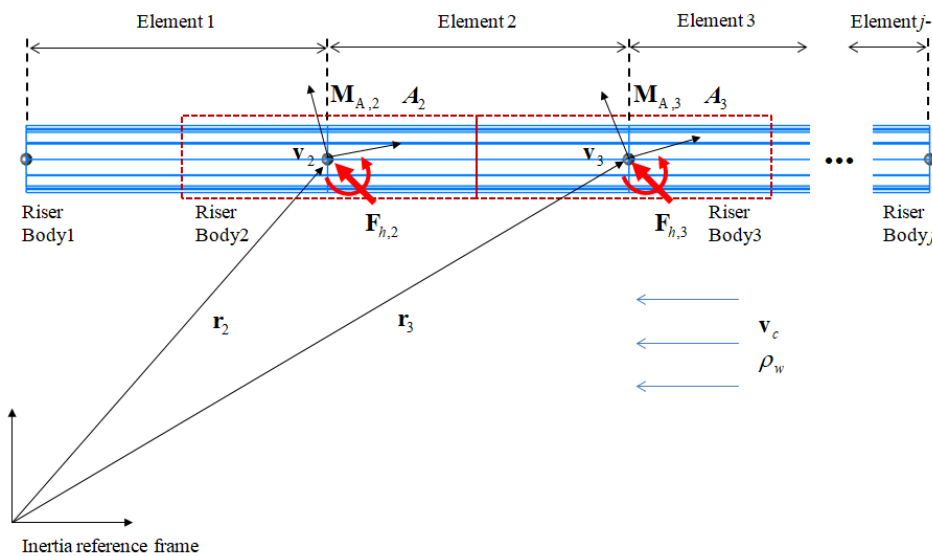
Figure 6. Hydrodynamics and kinematic relationship in riser system.